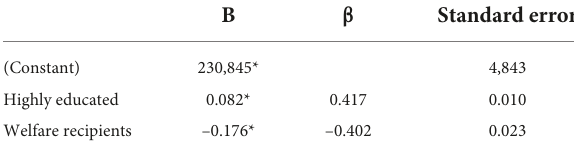
TABLE 1 Regression output for GAS 2018. TABLE 2 Regression output for GPA